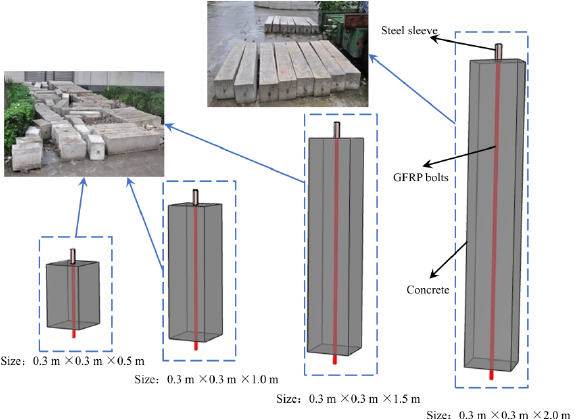
Figure 1. Specimen appearance.